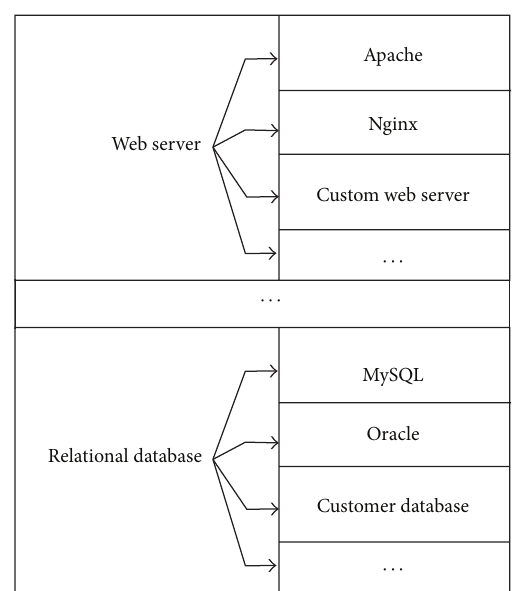
Figure 3: Example multimap